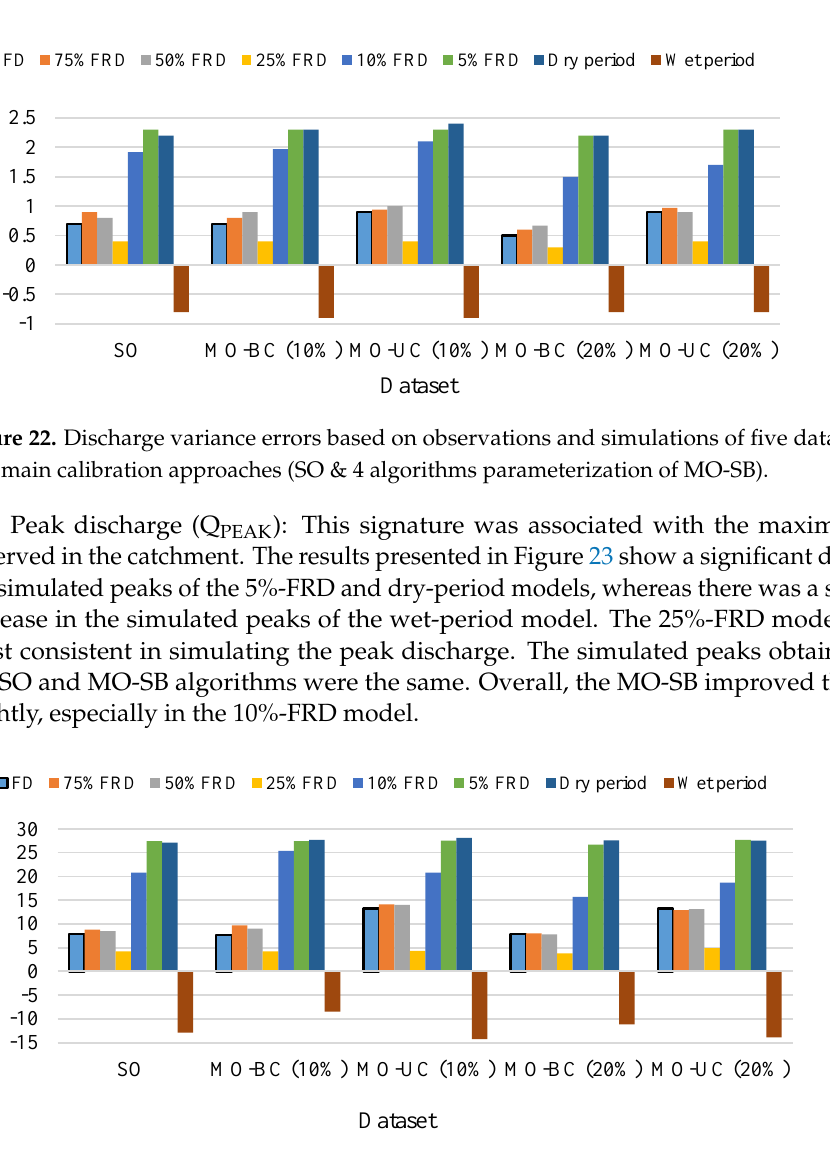
Figure 23. Peak discharge errors based on observations and simulations of five datasets using two main calibration approaches (SO & 4 algorithms parameterization of MO-SB).